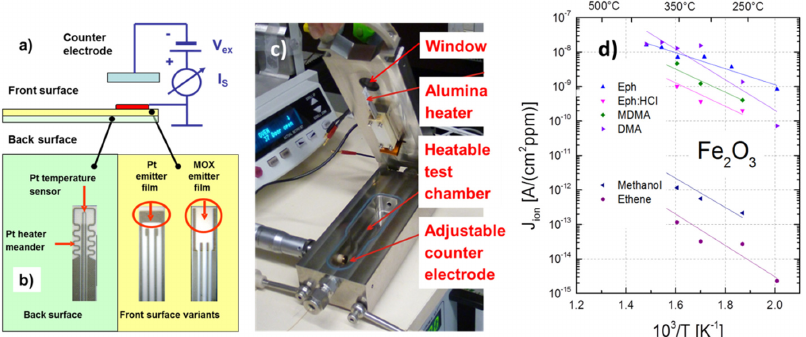
Figure 16. ( a , b ) Architecture of MOX sensors with SI readout; ( c ) measurement chamber for SI gas sensing tests. The active sensing area, determined by the size of the adjustable counter electrode, is ~10 mm 2 ; ( d ) Ionization current density as a function of the temperature of a Fe 2 O 3 emitter film. Amine-containing analytes (upper group) and non-amine-containing ones yield vastly different ion current densities.